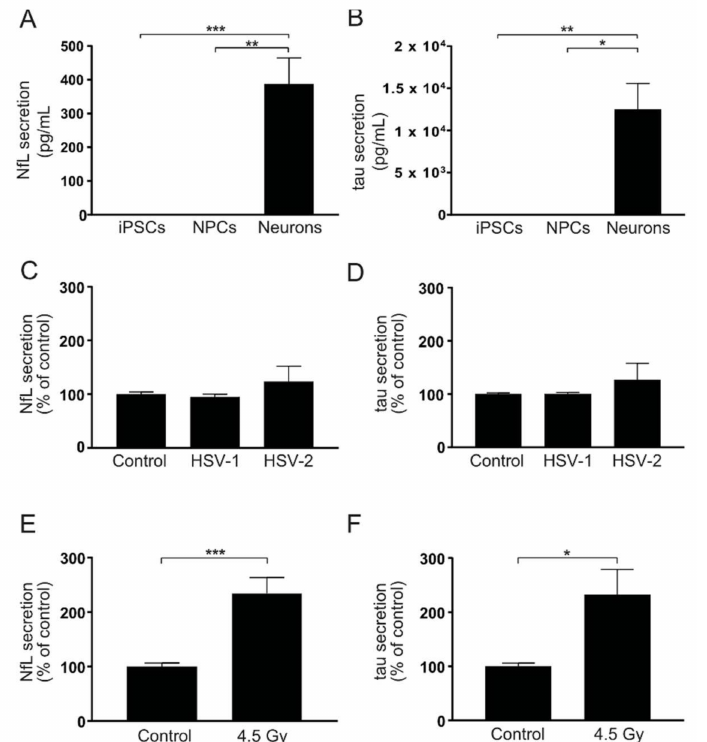
Figure 6. HSV infection does not induce secretion of axonal-injury markers in iPSC-derived cortical neurons. ( A , B ) NfL and tau measured in the cell-conditioned medium from iPSCs, NPCs and neurons. NfL (A) and tau ( B ) are actively secreted by neurons but not by iPSCs or NPCs. Bars represent mean of six (iPSCs), four (NPCs) or five (neurons) separate experiments from two iPSC lines +/ − SEM. ( C , D ) NfL and tau measured in cell-conditioned medium from neurons 48 h after infection with HSV-1 or HSV-2 at MOI = 0.1. No significant differences in secretion of NfL ( C ) or tau ( D ) were observed between infected and non-infected neurons. Bars represent mean of three separate differentiations from two iPSC lines +/ − SEM. ( E , F ) NfL and tau measured in the cell- conditioned medium from neurons after a single irradiation insult with 4.5 Gy. Both NfL ( E ) and tau ( F ) secretions increased significantly compared to control 48 h after irradiation. Bars represent mean of four separate differentiations from three iPSC lines +/ − SEM. * p < 0.05, ** p < 0.01 and *** p < 0.001 from Student’s t